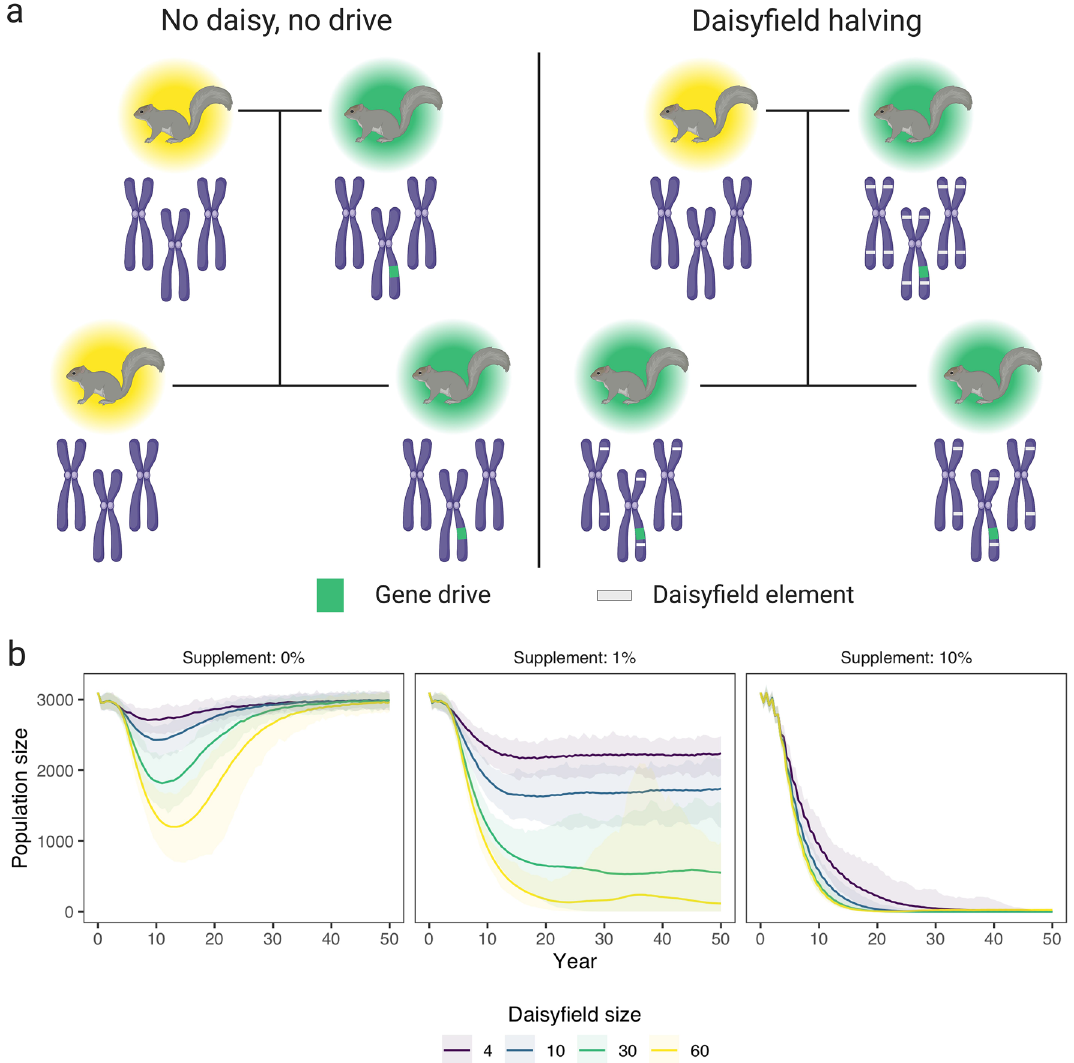
Figure 4. ( a ) Two key aspects of a daisyfield gene drive: no daisy, no drive, and the halving of the daisyfield each mating with a wildtype individual. If there are no daisy elements in the genome, there is no drive due to the absence of a gRNA. Daisy elements are scattered throughout the genome (forming a daisyfield) and inherited in a Mendelian fashion. Therefore, offspring inherits half of the daisy elements from each parent. Thus, after enough matings with wildtype individuals, there will be no daisy elements left. ( b ) Population size over time after the introduction of 100 squirrels with a HD-ClvR gene drive to a population of carrying capacity 3000. Lines represent the average population size over 100 model replications, while opaque ribbons represent the 95% quantiles. The model was run with an NHEJ rate ( P n ) of 0.02, 1 homing gRNA, and 4 cleave-and-rescue gRNAs. Gene drive squirrel supplementation was done yearly, the amount being a percentage (0, 1, or 10%) of the total population size at that